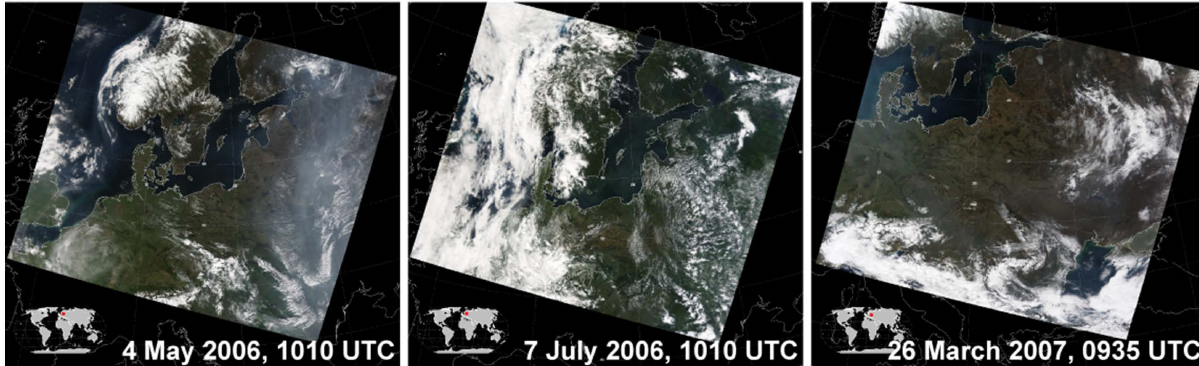
Fig. 2. MODIS visible composite pictures over Europe for (a) 4 May 2006, (b) 7 July 2006 and (c) 26 March 2007.